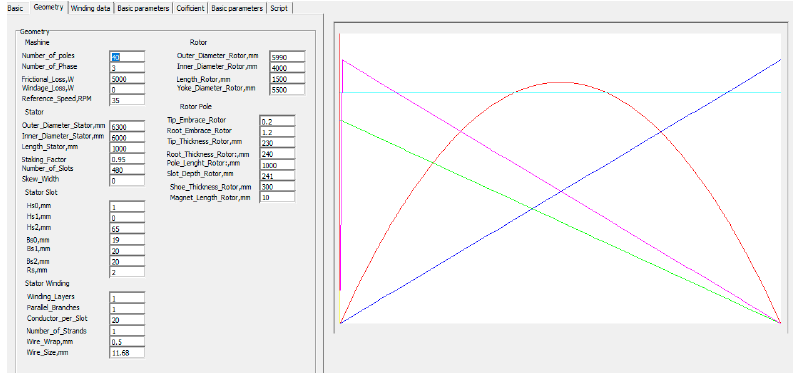
Figure 3. The result of optimization for CPSM.